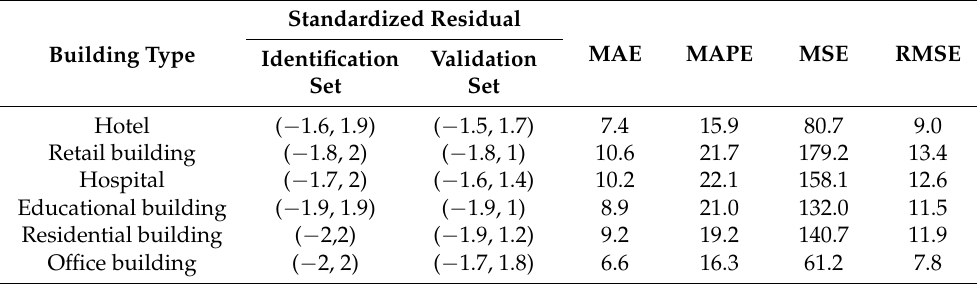
Table 10. Validation results of climate sub-model.